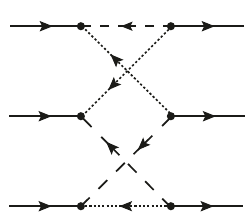
Figure 6 . Diagrams inserted inside three legs of (cid:12)gure 1.